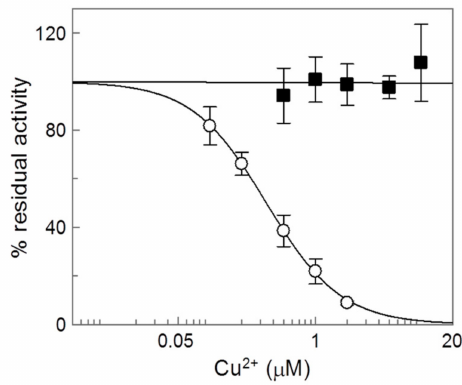
Figure 8. Dose-response analysis of copper e ff ect on the C-less mutant of CAC. ( ( (cid:4) ) C23V / C58V / C89S / C136V / C155V / C283S. After 1 min of incubation with Cu 2 + at the indicated concentrations, transport activity was measured by adding 0.1 mM [ 3 H]-carnitine and stopped after 30 min as described in Materials and Methods. Percent of residual activity with respect to the control, without Cu 2 + treatment, was reported. The values were the means ± SD from three